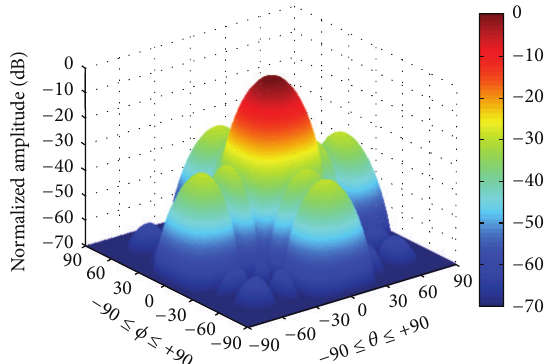
Figure 4: Three-dimensional antenna radiation pattern for 6 × 6 planar array